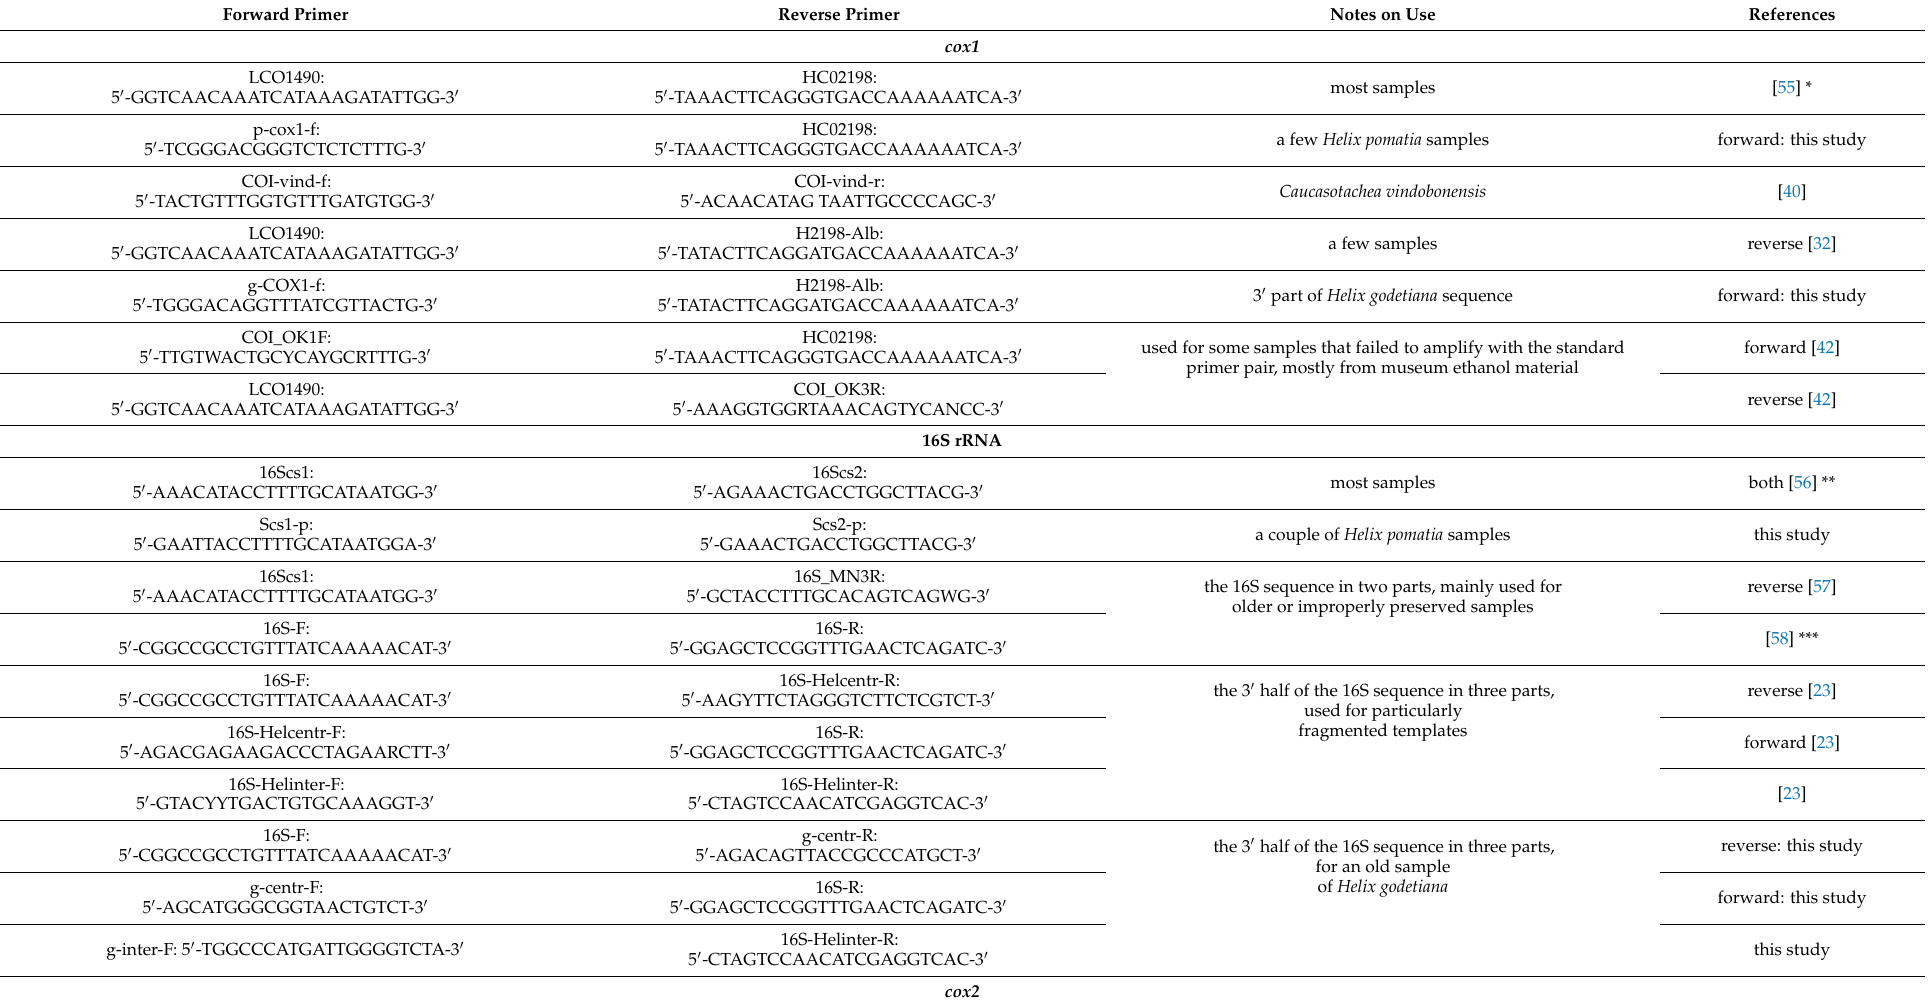
Table 1. List of primer pairs used for PCR